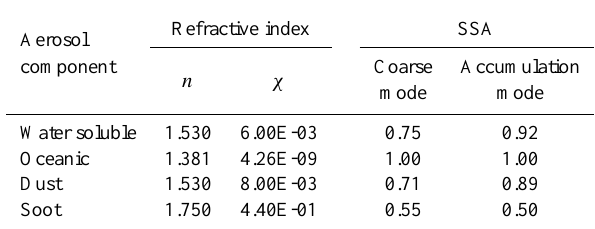
Table 1. SSA, real n and imaginary χ part of the refractive index for coarse and accumulation mode of water soluble, oceanic, dust and soot aerosol components at 550nm.